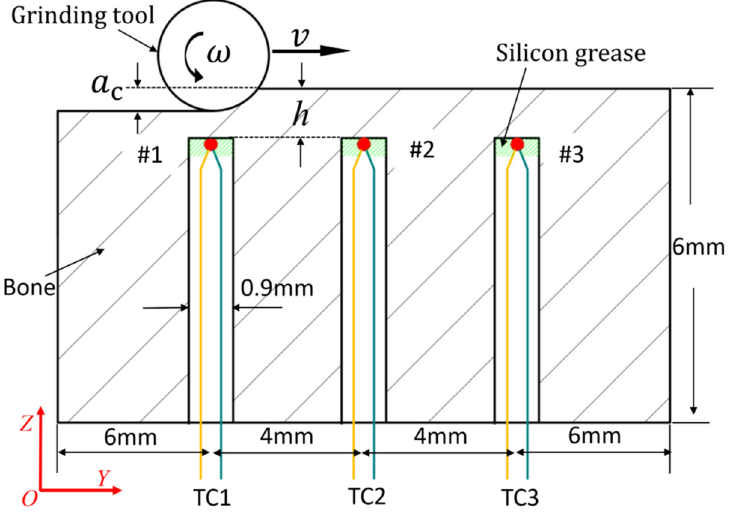
Figure 4. Schematic view of thermocouples’ arrangement.